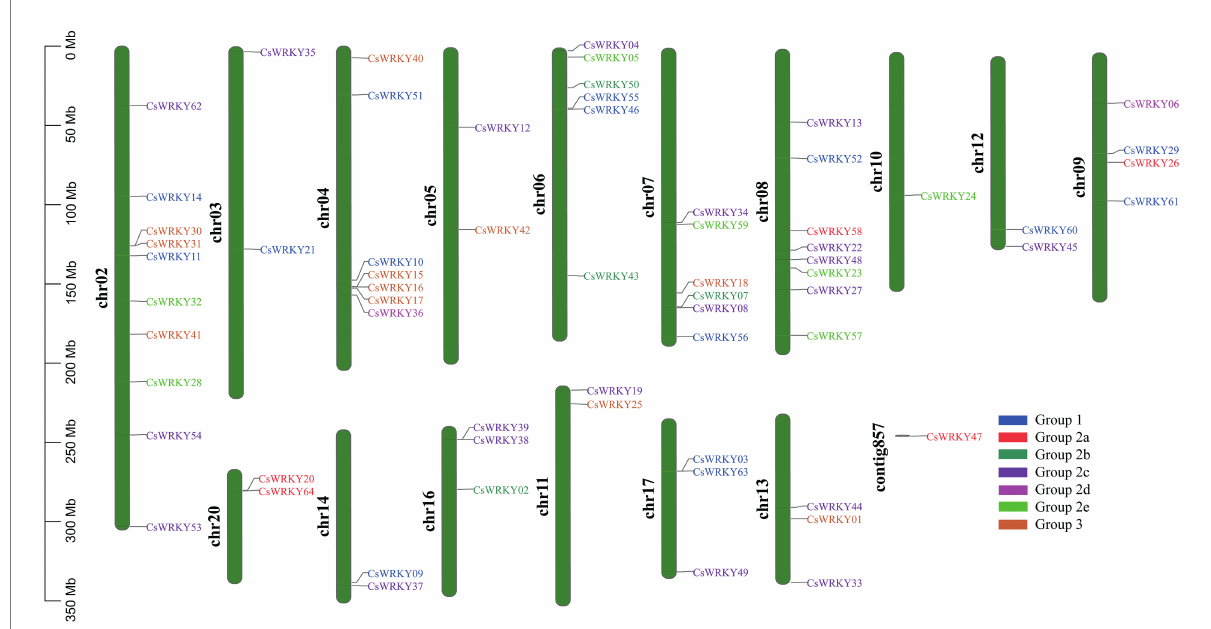
FIGURE 2 The chromosomal distribution and positioning of CsWRKYs across all seven chromosomes of C. sinense . A total of 16 chromosomes and one contig with varying lengths are shown in Mb (million base pair) scale on the left, where individual chromosomes (bars) are labeled with respective CsWRKY genes. The subfamily members are presented in various